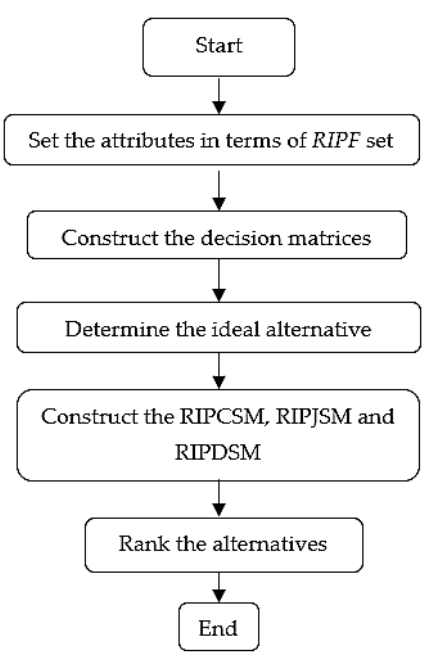
Fig 1. A flowchart of the proposed decision making.